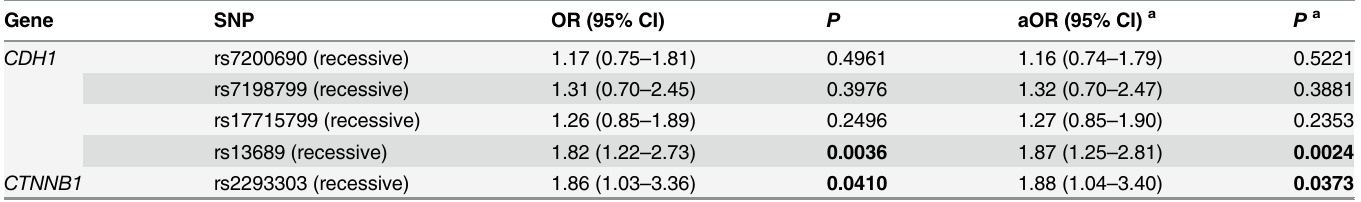
Table 2. Multiple logistic regression analyses including all the 5 at-risk SNPs in full